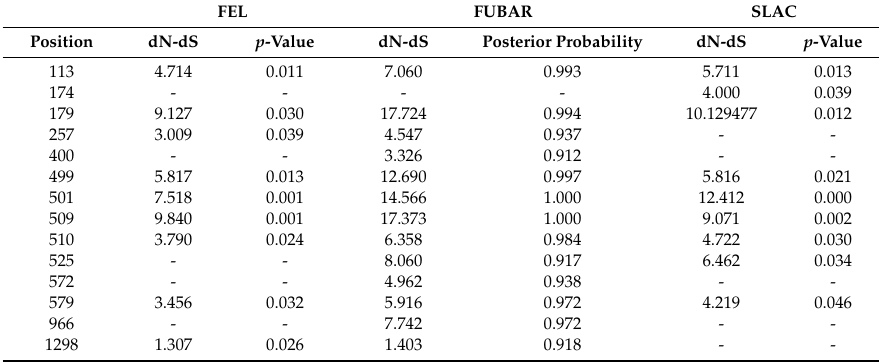
- Non-significant pressure with the specific method.